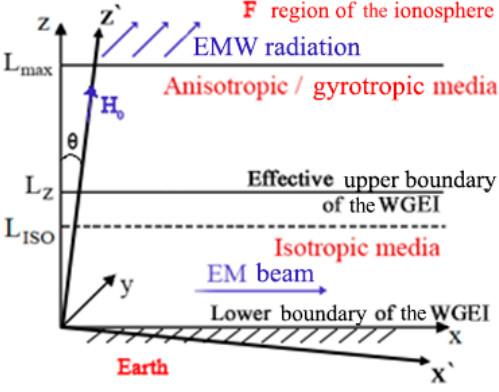
Figure 1. The geometry of the anisotropic and gyrotropic waveg- uide. EM waves propagate in the OX direction. H 0 is the exter- nal magnetic field. The effective WGEI for EM waves occupies the region 0 < z < L z . The isotropic medium occupies the region 0 < z < L ISO , L ISO < L z . The anisotropic and gyrotropic medium occupies the region L ISO < z < L max . The covering layer occu- pies the region L z < z < L max . WGEI includes the isotropic region 0 < z < L ISO and a part of the anisotropic region L z < z < L max . It is supposed that the anisotropic region is relatively small part of the WG, (L z − L ISO )/L z ∼ (0.1–0.2). At the upper boundary of the covering layer ( z = L max ) EM radiation to the external region ( z > L max ) is accounted for with the proper boundary conditions. The integration of the equations describing the EM field propaga- tion allows for obtaining effective impedance boundary conditions at the upper boundary of the effective WG ( z = L z ). These bound- ary conditions effectively include all the effects on the wave prop- agation of the covering layer and the radiation (at z = L max ) to the external region ( z > L max